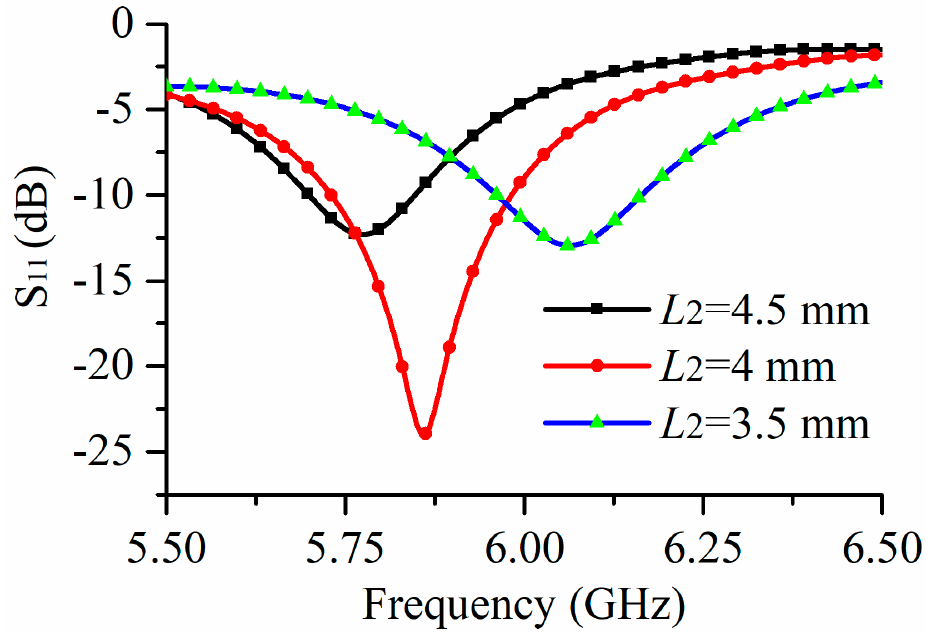
Figure 5. Simulation S 11 under different values of L 2 .